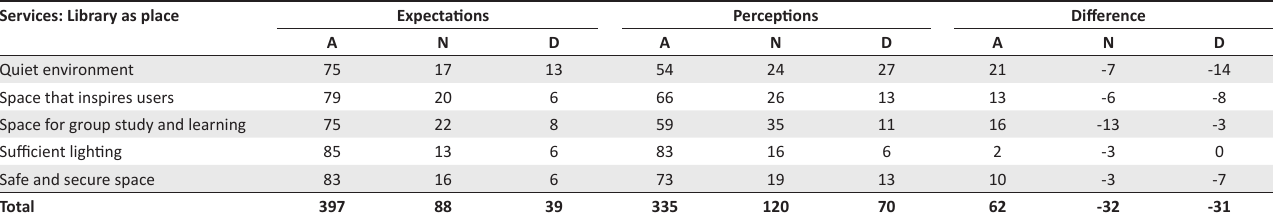
TABLE 5: Library as a place. Services: Library as place Expectations Quiet environment Space that inspires users Space for group study and learning Sufficient lighting